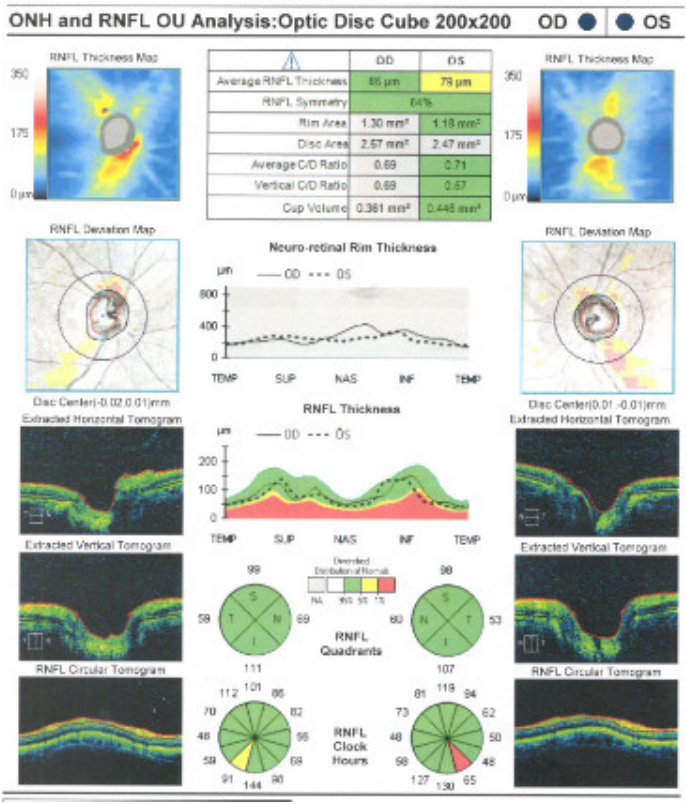
Medicina 2022 , 58 , 1837